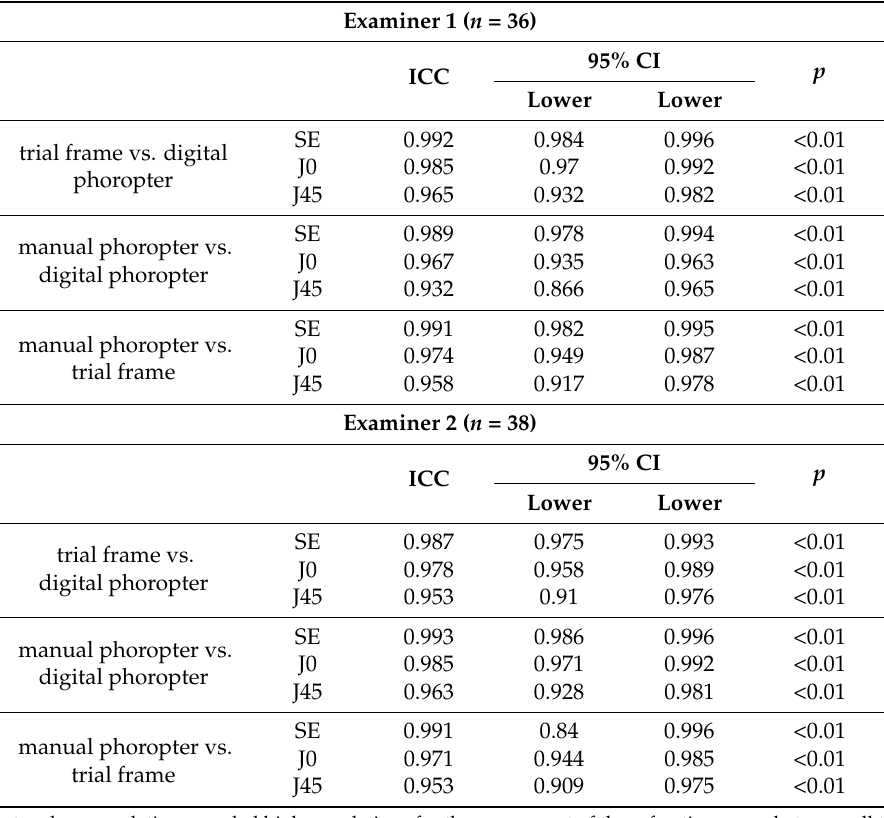
Table 3. Intra-Class Correlation, their lower and upper 95% CI interval, for the pairwise correlation of each device, separated for the two examiners and for the power vector components of refraction SE, J0 and